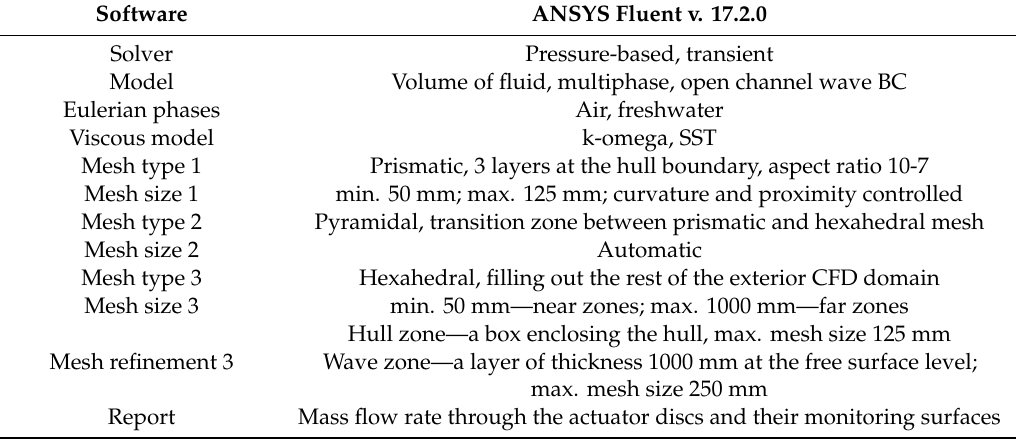
Table 3. CFD set-up parameters.